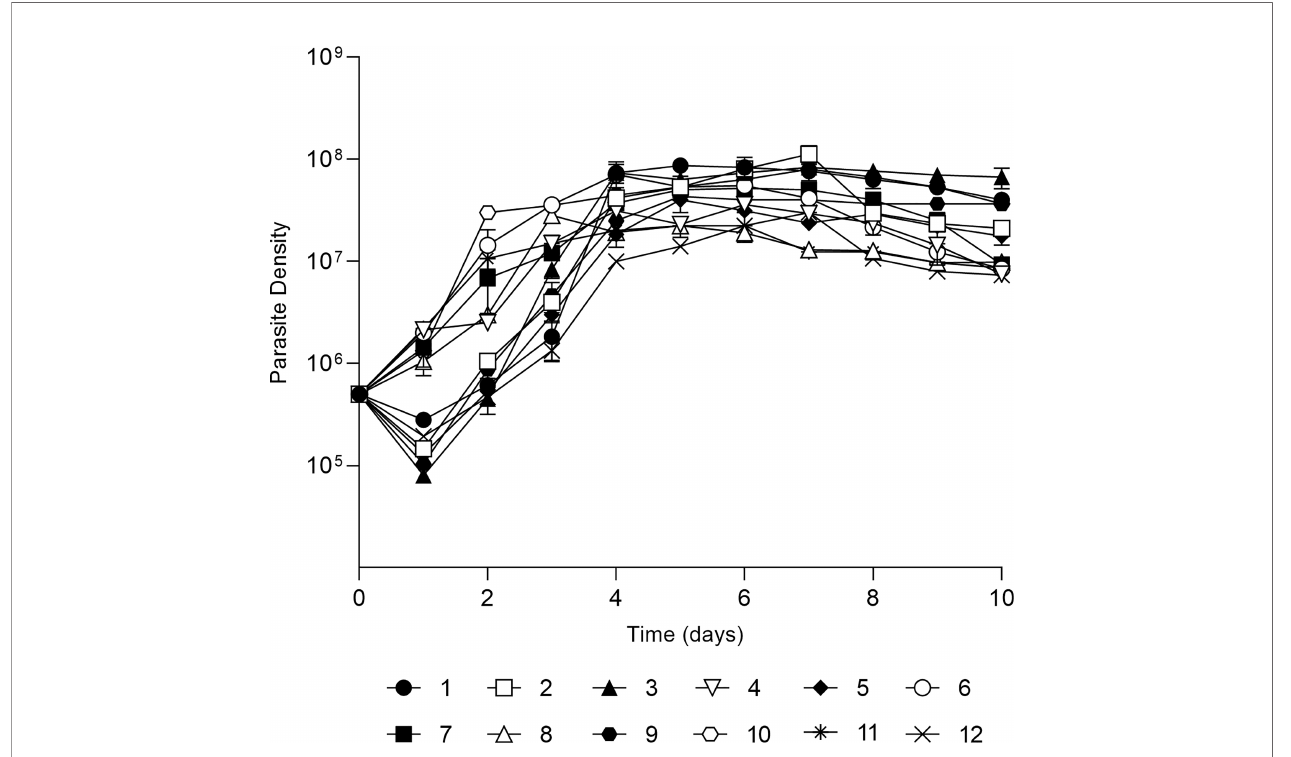
FIGURE 1 | In vitro development of 12 L. (V.) braziliensis clinical isolates. Growth curve of each isolate in Schneider ’ s medium, cultures started with 5x10 5 parasites per mL and growth was followed for 10 days with daily count of viable parasites in a Neubauer chamber. The values are representative of the mean and standard deviation of three independent